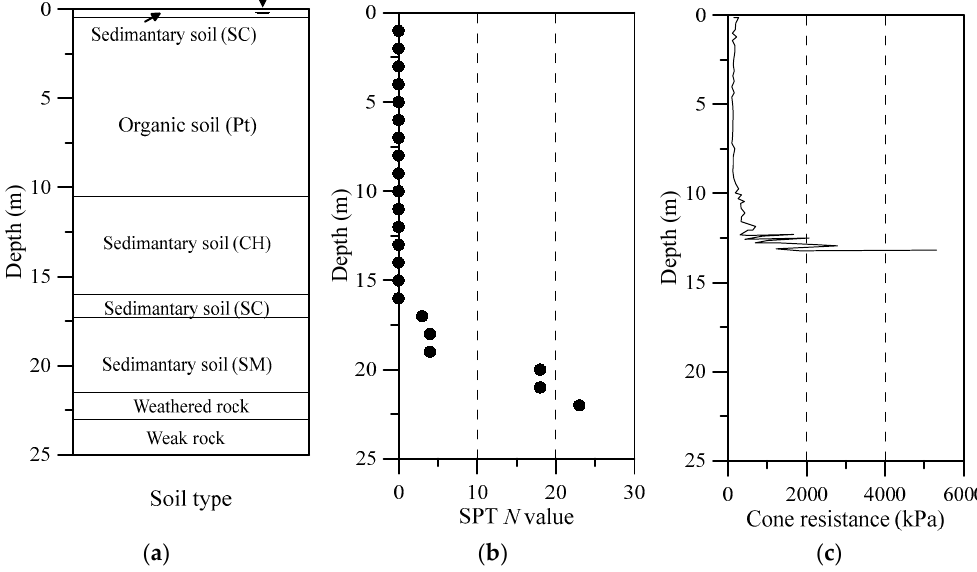
Figure 2. Soil profile with test results: ( a ) Soil profile; ( b ) result of N value; and ( c ) result of cone resistance.